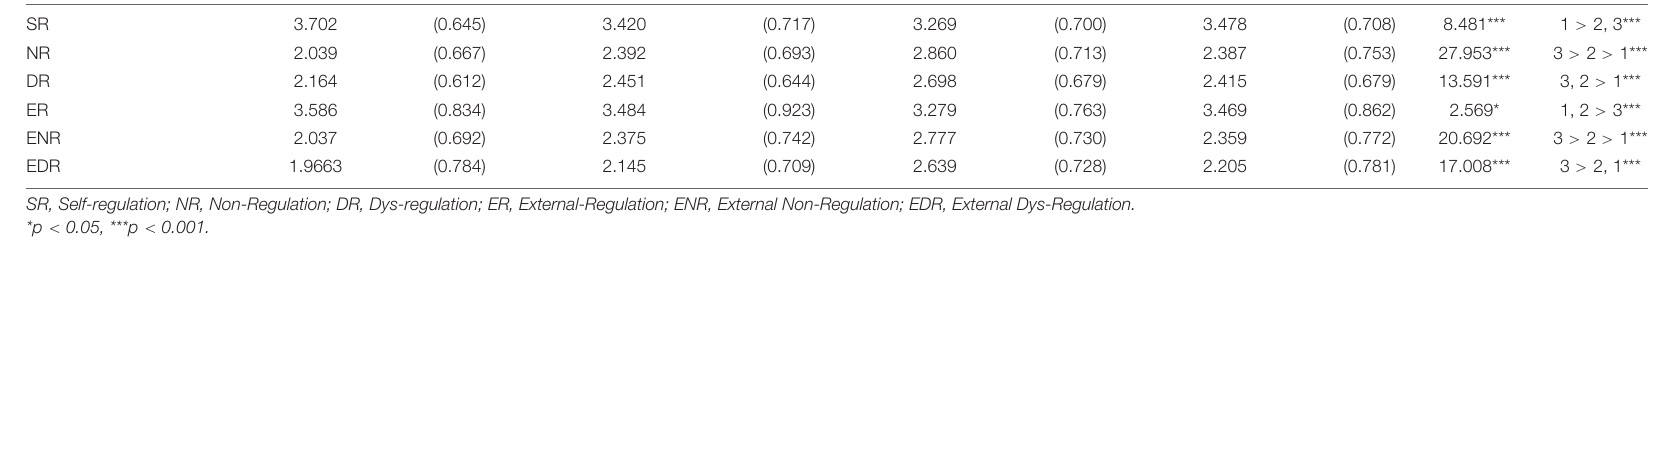
TABLE 9 | Effect of low–medium–high levels of the independent variable executive functions (EF) on SR-ER. Dependent variables